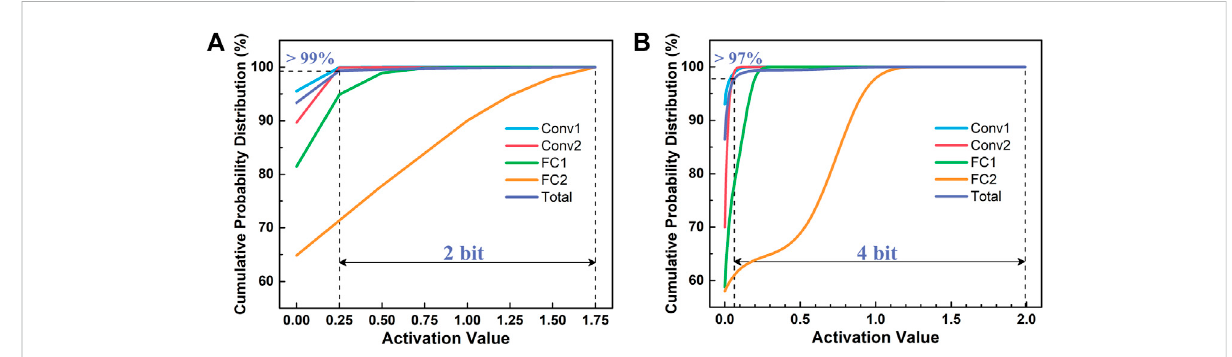
FIGURE 5 The layer-wise and total activation cumulative probability distributions of (A) W4A3 and (B) W8A8 cases, respectively. The activations are highly sparse, and over 99%/97% of the total values can be expressed with precisions 2-bit/4-bit lower than that of the maximum ones for the W4A3/ W8A8